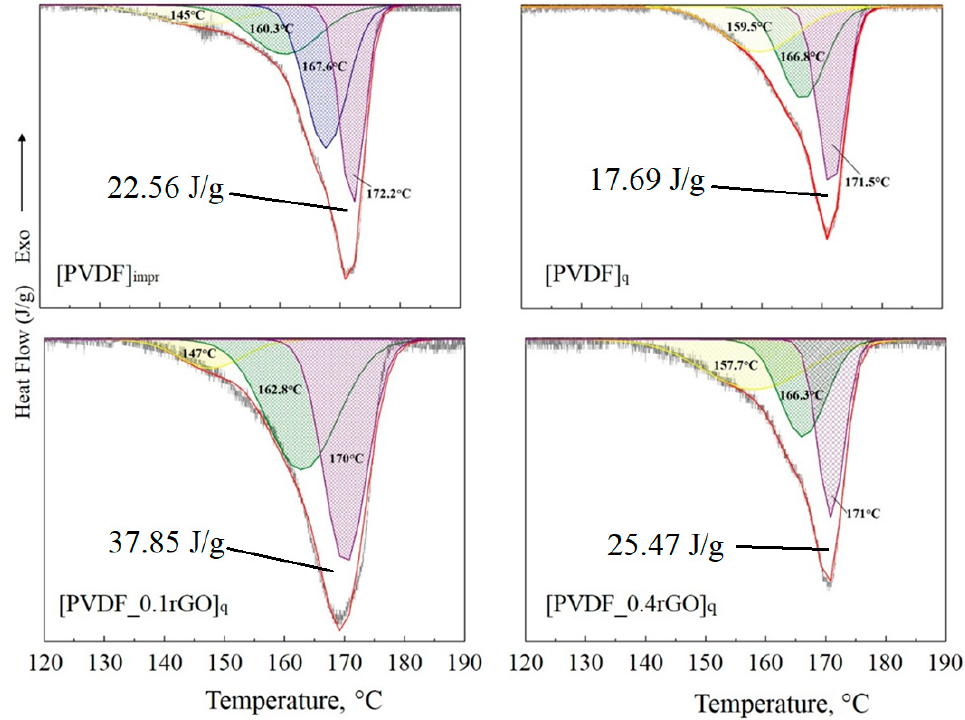
Figure 6. Differential scanning calorimetry (DSC) thermograms of the imprinted, quenched patterned PVDF films and the samples with 0.1 wt % and 0.4 wt % of rGO.